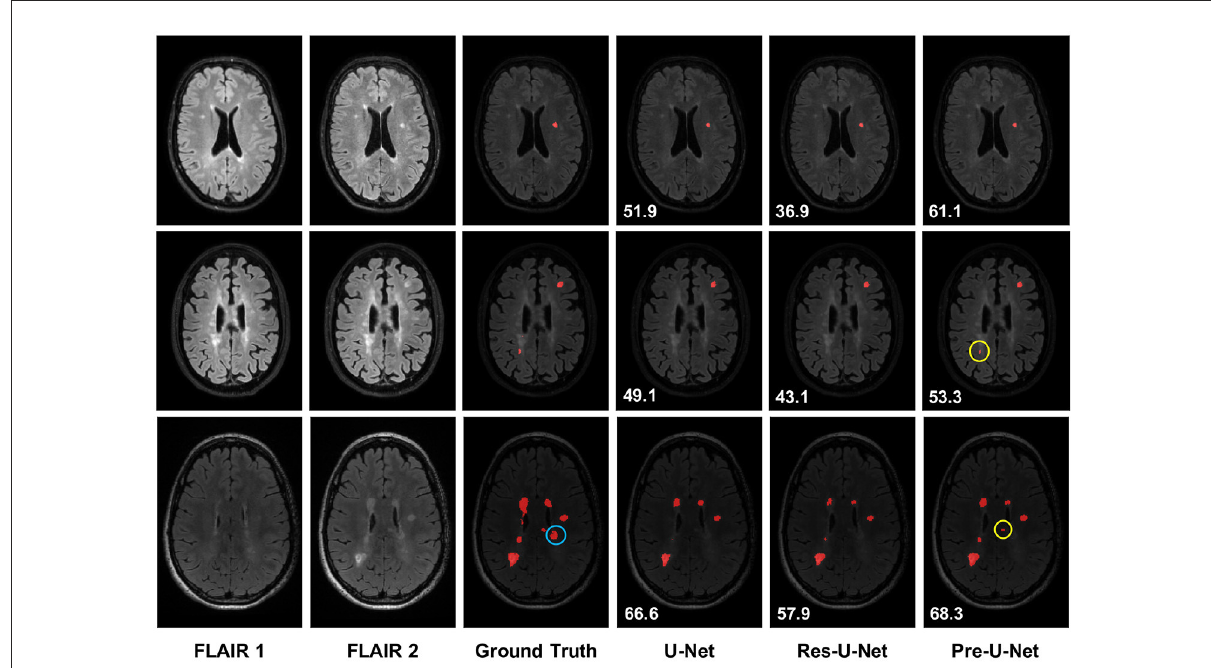
FIGURE1 Qualitative results on new MS lesion segmentation. The three examples are from three different patients in the test set. The new lesions are shown in red in the segmentation maps. The new lesions circled in yellow (rows 2-3 and column 6) are successfully detected only by Pre-U-Net, while the new lesion circled in blue (row 3 and column 3) is not captured by any of the models, representing a very difficult case. The patient-wise Dice score for each example is displayed on the segmentation